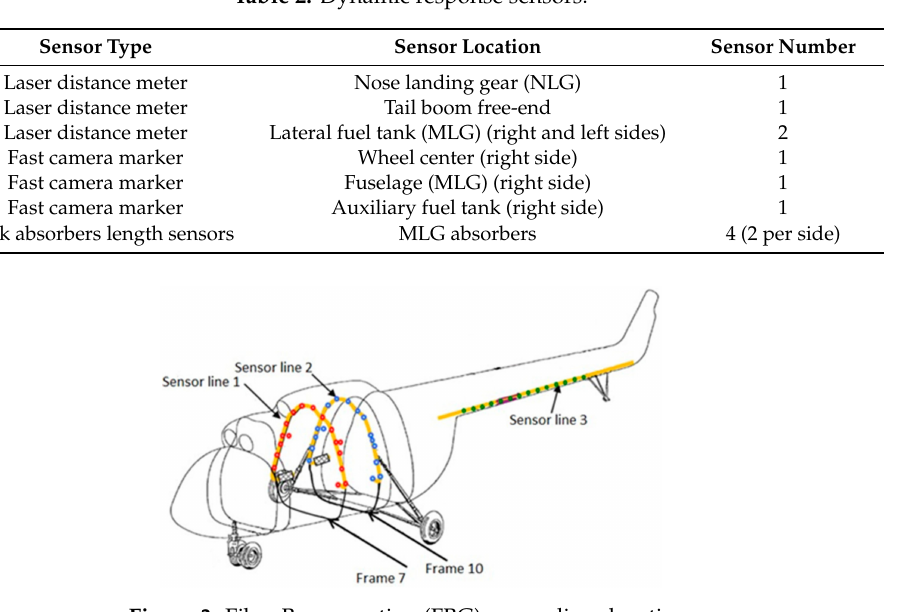
Figure 3. Fiber Bragg grating (FBG) sensor lines location. Table 3. Structural response